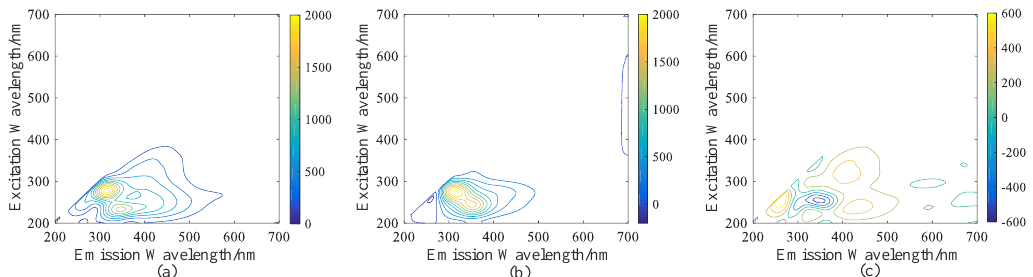
(b) Figure 11. 3D ( a ) and contour ( b ) diagrams of 20 μg/L phenol positioning result. The morphological grayscale reconstruction algorithm was used to further extract features from the spectrum and amplify the signal in the region of characteristic spectrum with an amplification factor. As the 3D fluorescence spectrum of drinking water contains two characteristic peaks, the number of factors in the algorithm was set to two. The modeling results and residual matrix of